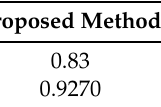
Table 7. The metrics of different methods for the top hat area in Figure